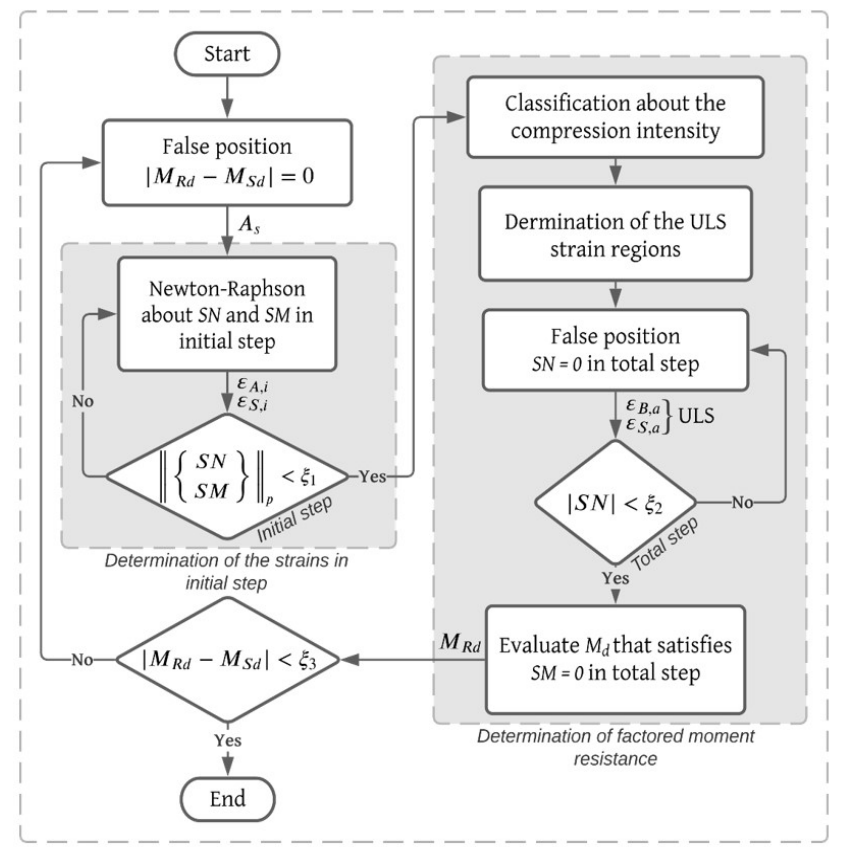
Figure 11. Flowchart of the composite section design